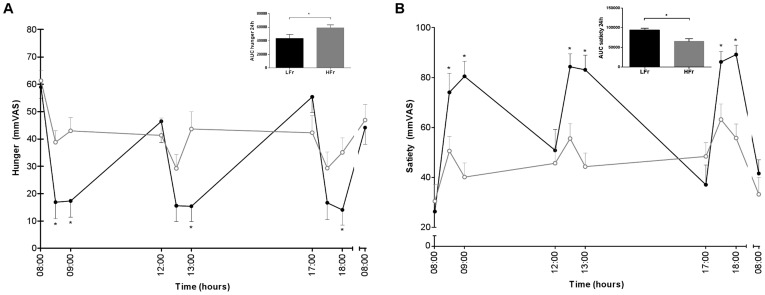
Hunger (A), and satiety (B) levels for 24 h and the AUCs of the LFr (dense black circle ) and HFr (open gray circle ) diet.*P<0.05 LFr vs. HFr diet. P-values were derived by analysis of mixed models for the 24 h profiles and by a paired t-test for the AUCs. aValues are expressed as mean±SEM.